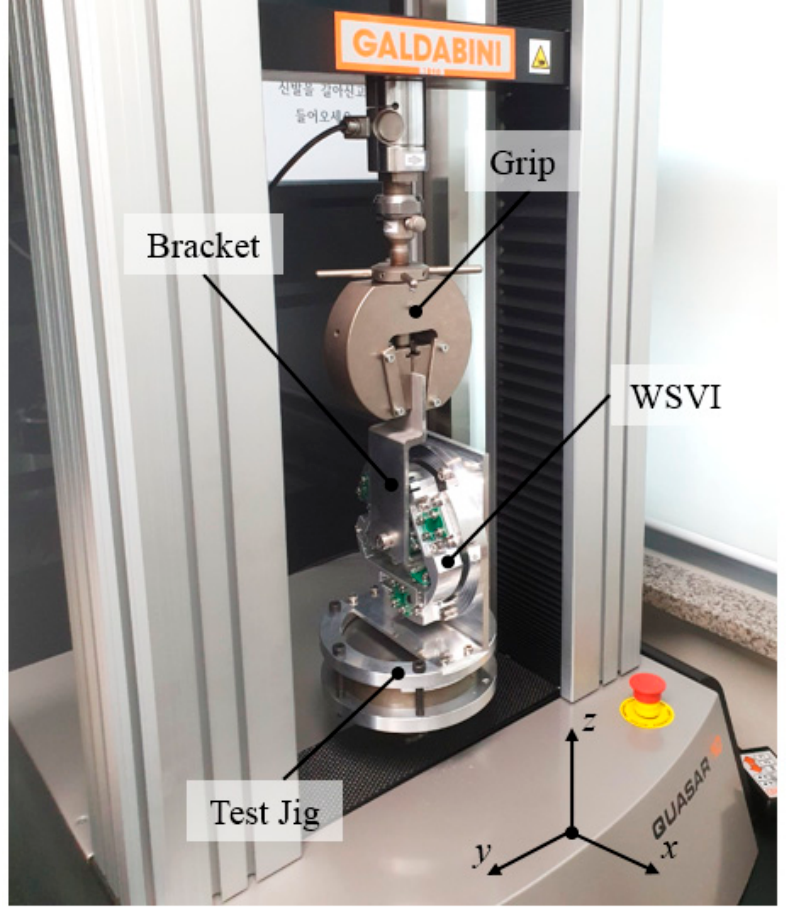
Figure 2. Example of the Static Load Test Setup for the Lateral Axis.